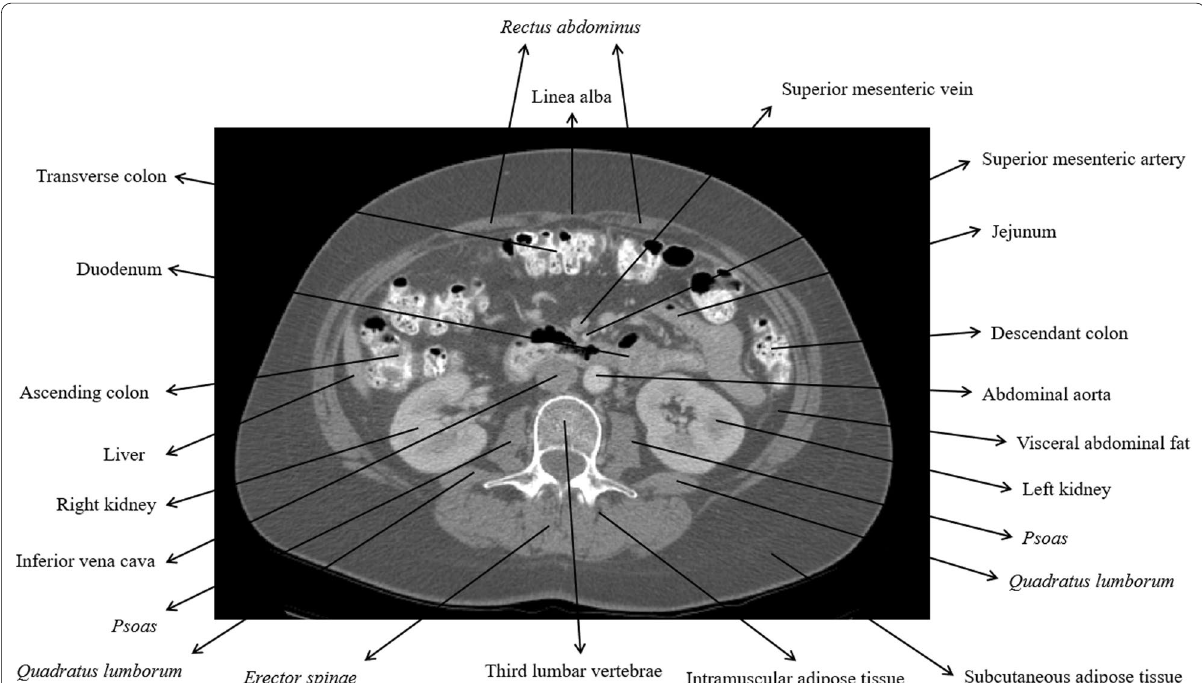
Fig. 2 Tissues and structures located in a computed tomography section at the level of the third lumbar vertebra